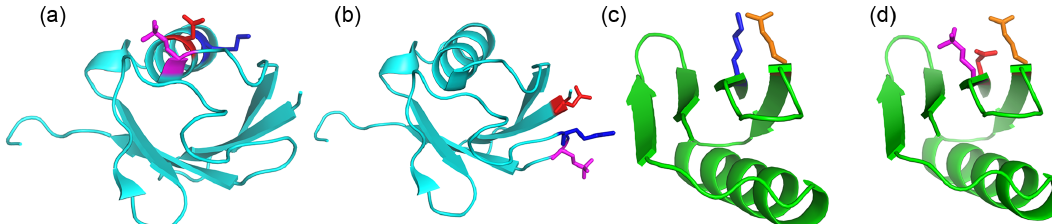
Figure 6. Single-site phosphoserine mutants tested for the effect of positively charged residues nearby. The locations of selected residues are highlighted by displaying side-chain atoms, with phosphoserine in magenta, aspartate in red, glutamate in orange and lysine residues in blue. Side-chain conformations are those of the crystal structure, except for phosphoserine, which was modelled. (a) Ubiquitin T22Sep/N25D. A lysine residue (Lys29) is located next to the engineered lanthanide-binding site in the same α -helix, where it can form a salt bridge with residue 25. (b) Ubiquitin Q2D/E64Sep. There is a lysine residue in position i -1 of the Sep residue. (c) Wild-type GB1 showing the salt bridge between Lys4 and Glu15. (d) GB1 K4D/I6Sep. Introduction of the aspartate and Sep residue resulted in denaturation of the protein (Fig.